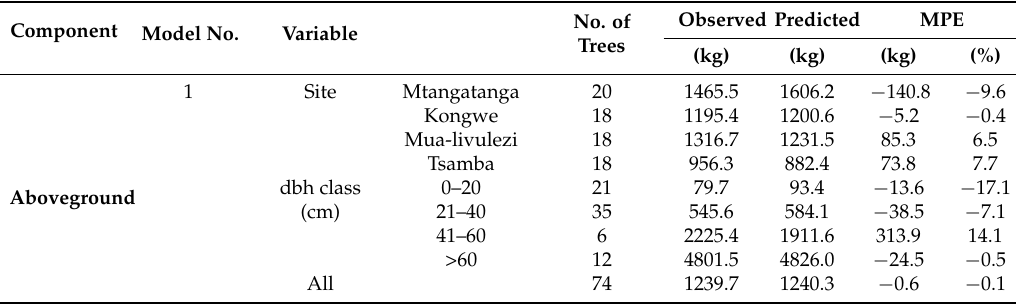
Table 7. Mean prediction errors (MPE) of the models over study sites and dbh